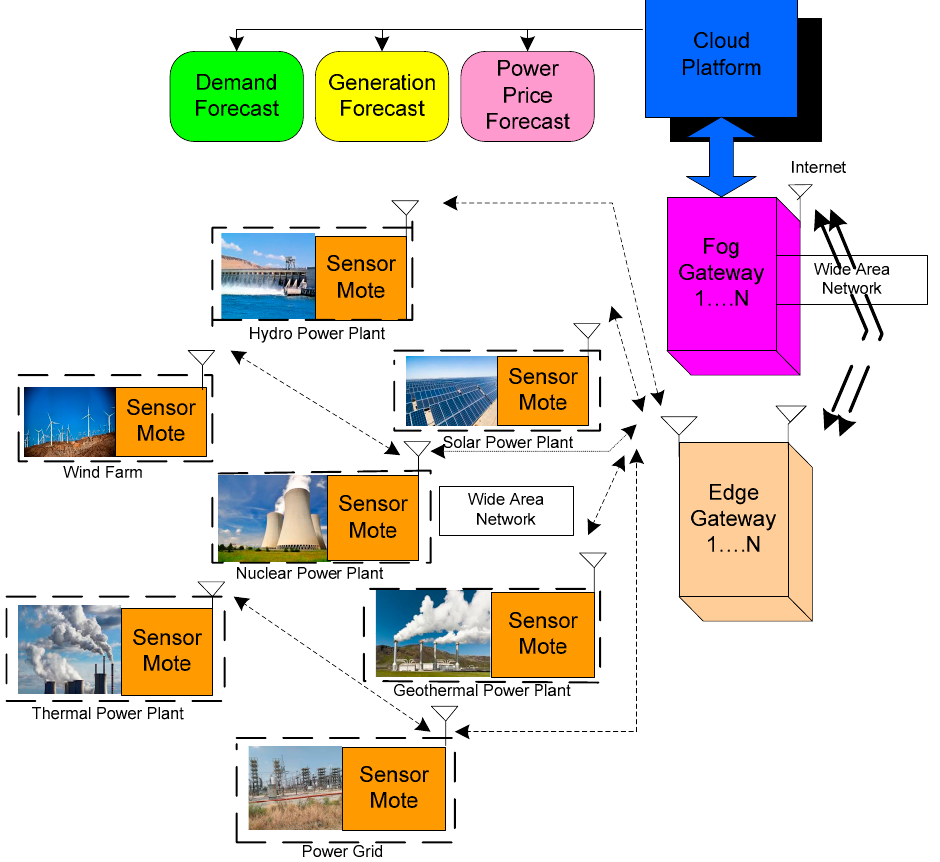
Figure 4. IoT based on Real-time monitoring of generation stage using edge and fog